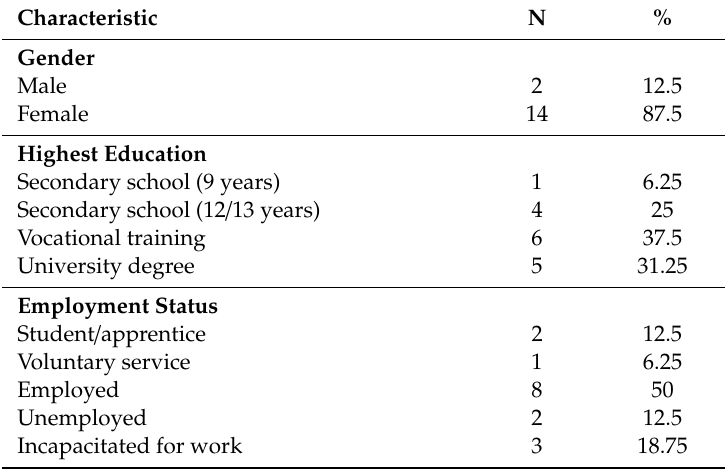
Table 1. Demographical and clinical characteristics of the sample (N =